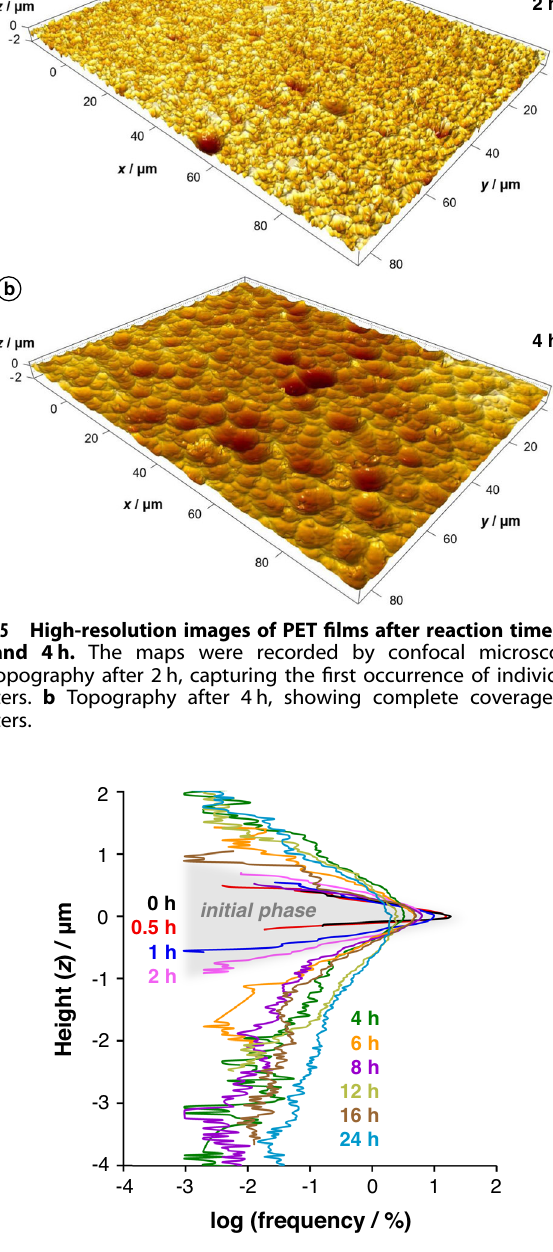
Fig. 6 Histograms of height distributions for PET fi lm surfaces after reaction times from 0 to 24 h. With the height mode centred to zero, positive and negative z values represent hills and dales, respectively. The semi-logarithmic plots display the evolution of high-reactivity centres (tailing towards lower z values) in the advanced degradation can be taken from the height histograms shown in Fig. 6. Here, the z positions were centred to the maximum frequency after subtracting the modal value of the total retreat. For a sound statistic comparison, the class intervals were uni fi ed, and global tilts or bowings were removed beforehand where necessary. (A corresponding analysis for a larger reference area is shown in Supplementary Fig. 2, together with the respective 2D VSI maps.)